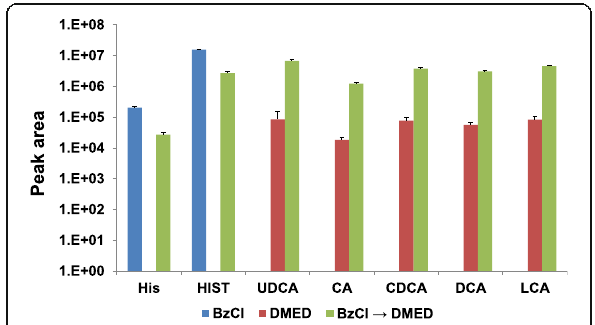
Fig. 3 Comparison of individual and serial derivatization